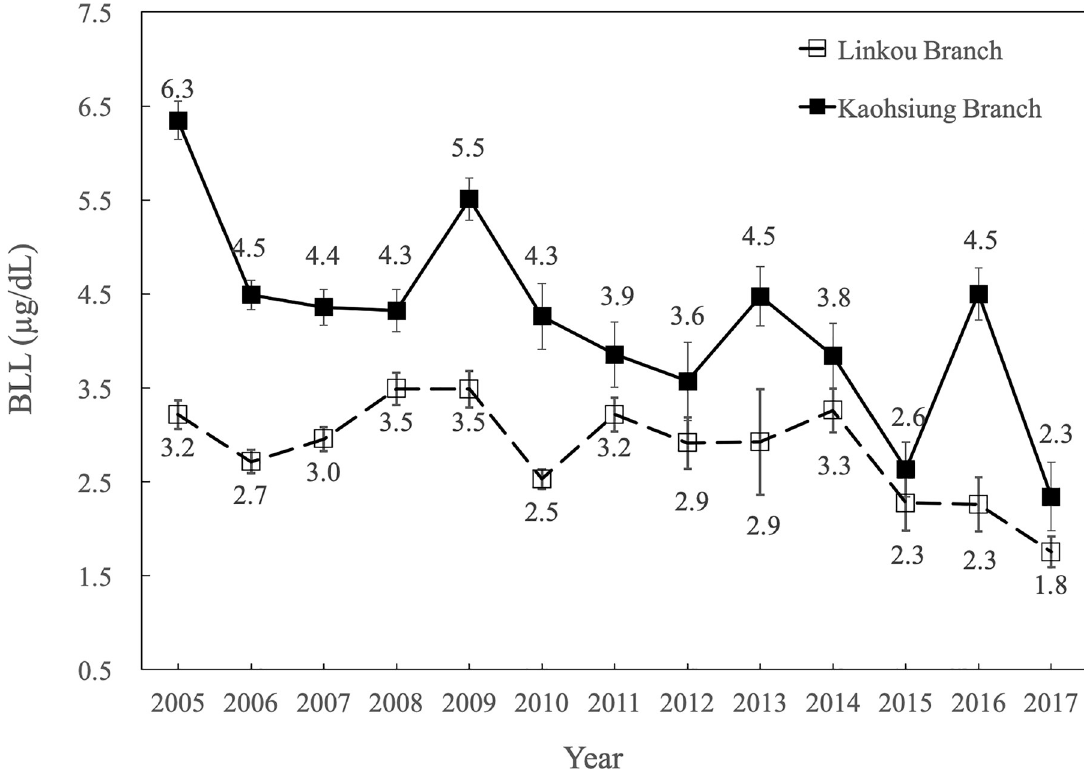
Fig 1. Trend of blood lead levels (BLLs). The figure shows the trend of BLLs in Taiwanese adult, 2005–2017. The differences between the means of BLLs in each year were examined by one-way analysis of variance test. A significant continuous decreasing trend (P < 0.001) was noted. Furthermore, the mean BLLs of the Kaohsiung branch were higher than those of the Linkou branch throughout the indicated periods [odds ratio (OR): 7.882; 95% CI (confident interval):